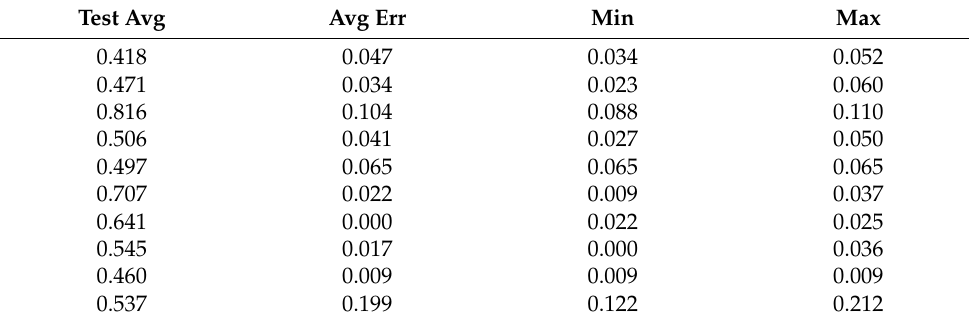
Table A224. Set 3, trials 41–50 data (average actual PR values).